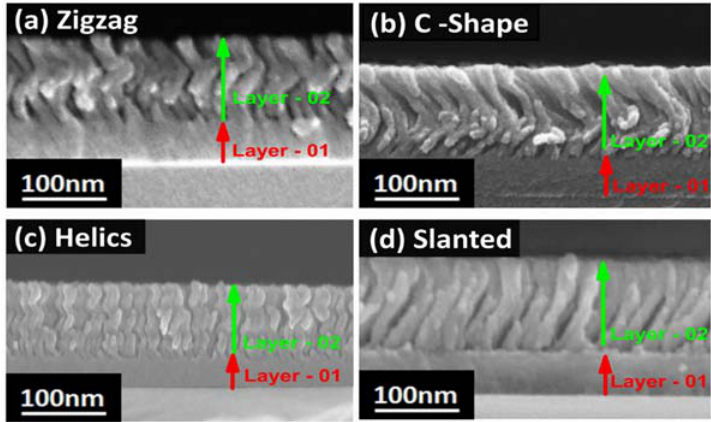
Figure 4. Bilayer SiO 2 AR coatings having different morphologies on BK7 substrate: ( a ) nanozigzag, ( b ) C ‐ shape, ( c ) nanohelix, and ( d ) slanting nanostructure.